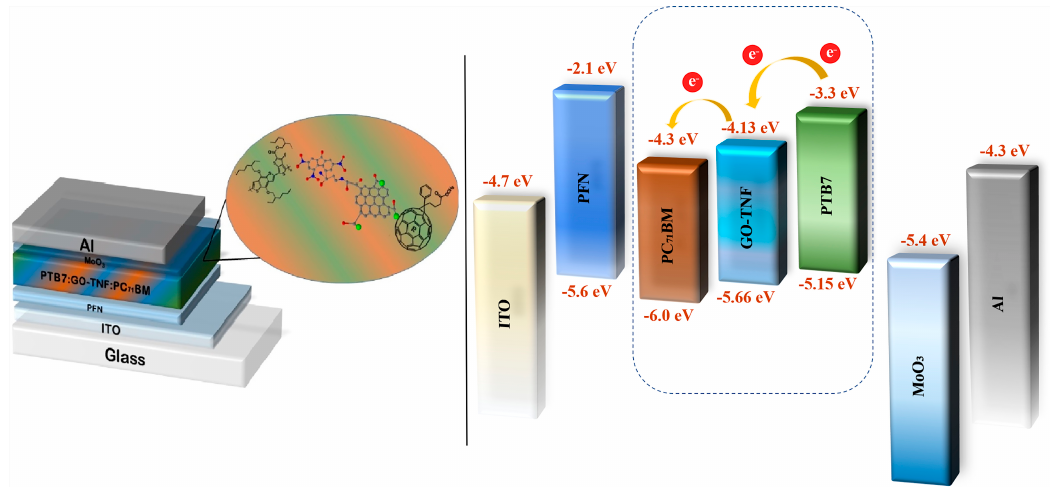
Figure 2. Schematic representation of the ternary OSC device ( left ) and energy levels diagram ( right ).